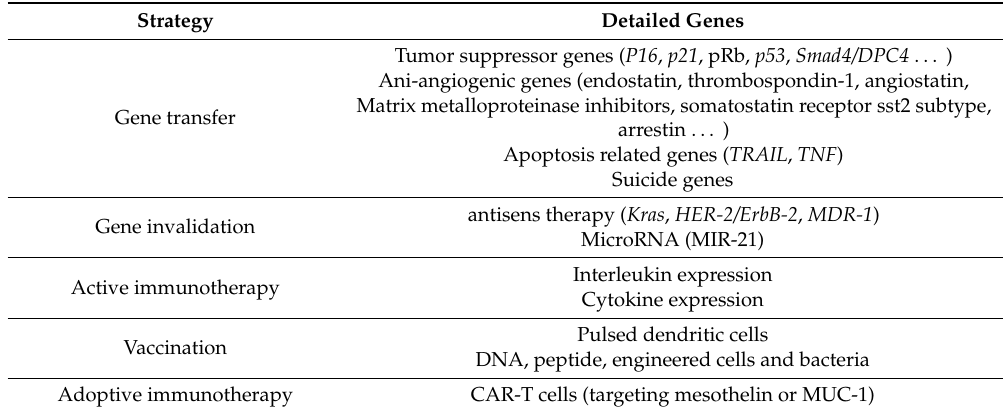
Table 2. Main experiments and strategies tested for gene therapy of pancreatic